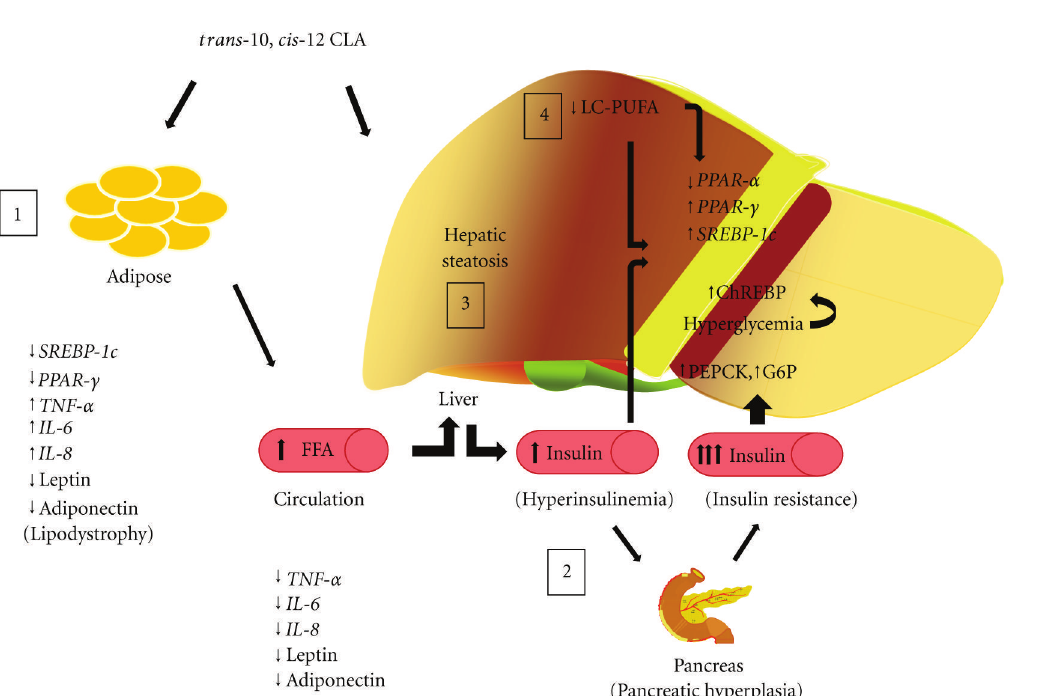
Figure 1: Current concepts in the pathways of trans -10 , cis -12 CLA-induced hepatic steatosis. (1) Adipose tissue lipodystrophy caused by increased proinflammatory cytokines and reduced adipokines leading to higher circulatory levels of free FA (FFA). (2) Hyperinsulinemia induced by systemic insulin resistance. (3) Alterations in hepatic lipid metabolism leading to hepatic steatosis. (4) Alterations in hepatic FA composition. SREBP-1c, Sterol regulatory element-binding protein-1c; PPAR- γ , peroxisome proliferator activated receptor- γ ; TNF- α , tumor necrosis factor- α ; IL-6, interleukin-6; IL-8, interleukin-8; PEPCK, phosphoenol pyruvate carboxykinase; G6P, glucose 6-phosphatase; ChREBP, carbohydrate response element-binding protein; PPAR- α , peroxisome proliferator-activated receptor- α ; LC-PUFA, long chain polyunsaturated